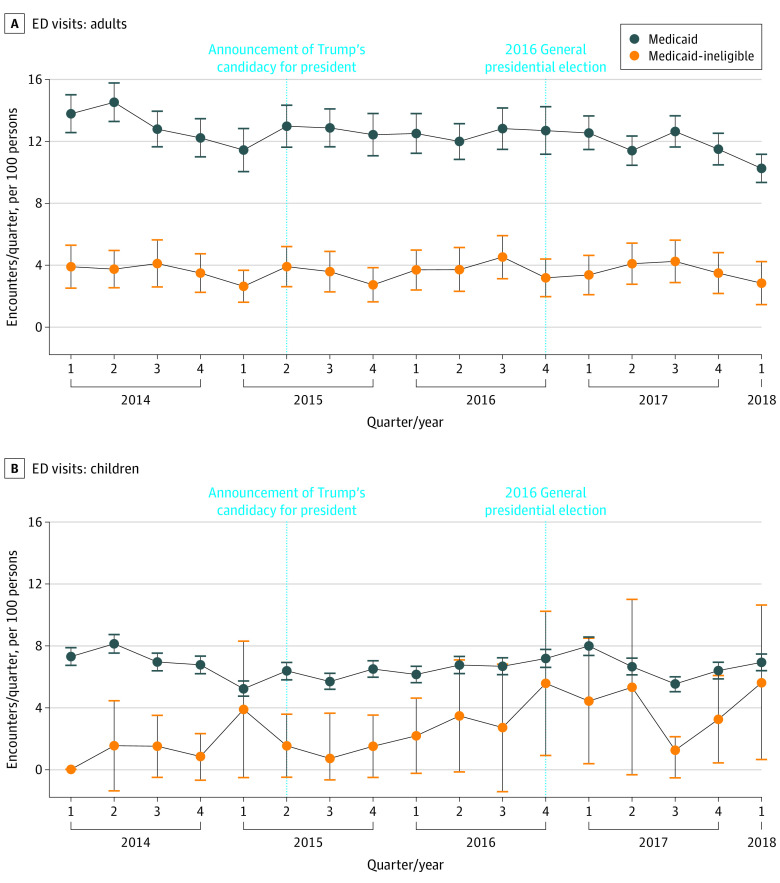
Adjusted Mean Number of Quarterly Emergency Department (ED) VisitsEmergency department visits for adults (A) and children (B). Error bars show 95% CIs.